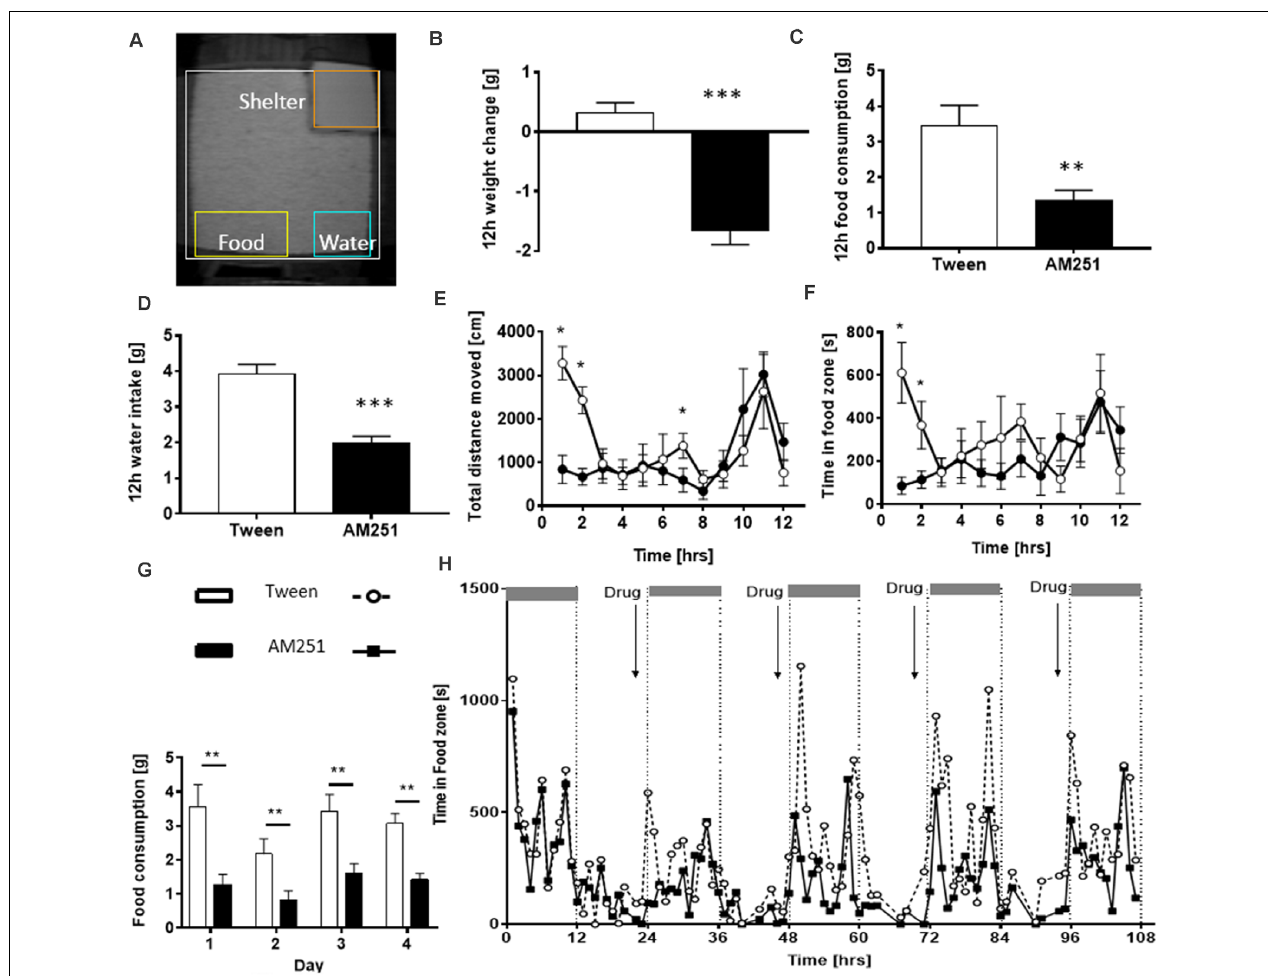
FIGURE 5 | Assessment of food and water consumption in the PhenoTyper. (A) Home-cage arena i ndicating the location of defined zones of interest including food and water zones adjacent to the food hopper and water bottle. Treatment with AM251 induced a decrease in body weight (B) , food intake (C) and water intake (D) . They also spent less time in the food zone compared with controls (E) and displayed lower levels of ambulatory activity (F) . Repeated administration of AM251 suppressed food intake (G) with home cage observations indicating a reduced time in food zone each night following drug treatment (H) . The figure is adapted from Riedel et al. (2009). * P < 0.05; ∗∗ P < 0.01; ∗∗∗ P <